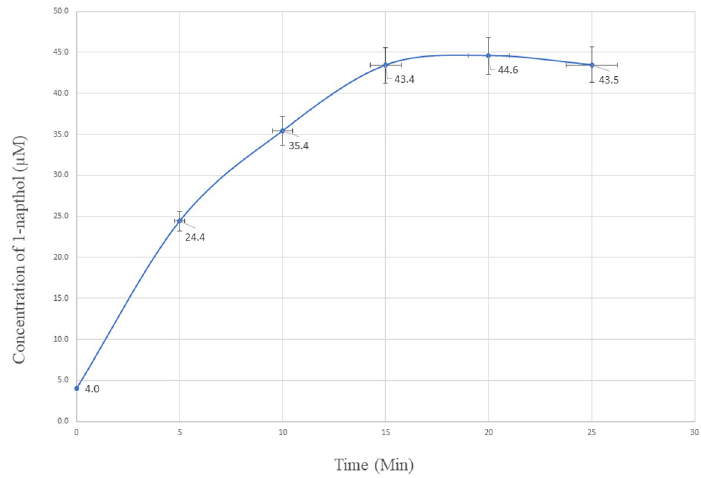
Fig 6. Concentration of 1-naphthol formed by AChE in blood at different time intervals.